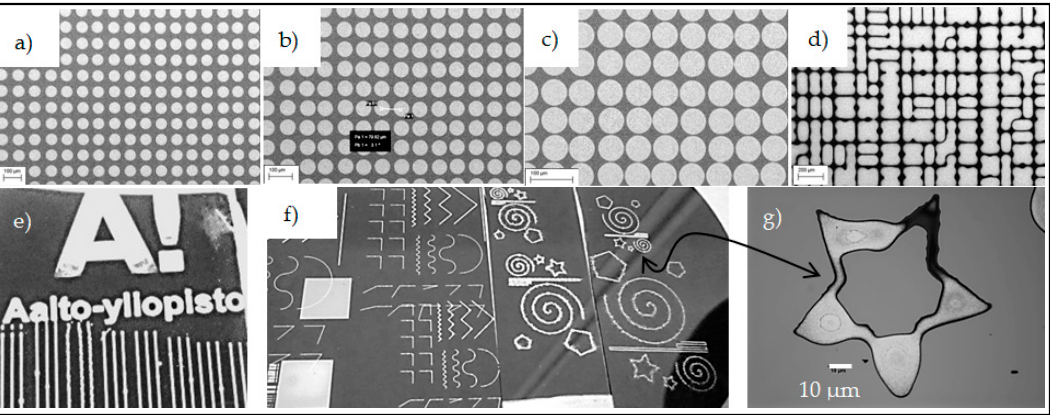
Figure 3. Printed individual droplets with 30 µm diameter and a center-to-center distance of ( a ) 100 µm; ( b ) 80 µm; ( c ) 70 µm and ( d ) Eventually droplets merged. Images of other printed patterns, ( e ) Logo of Aalto University; ( f ) Curves, angles, zigzags and stars; ( g ) Microscopic image of a printed star showing minimum possible feature size.